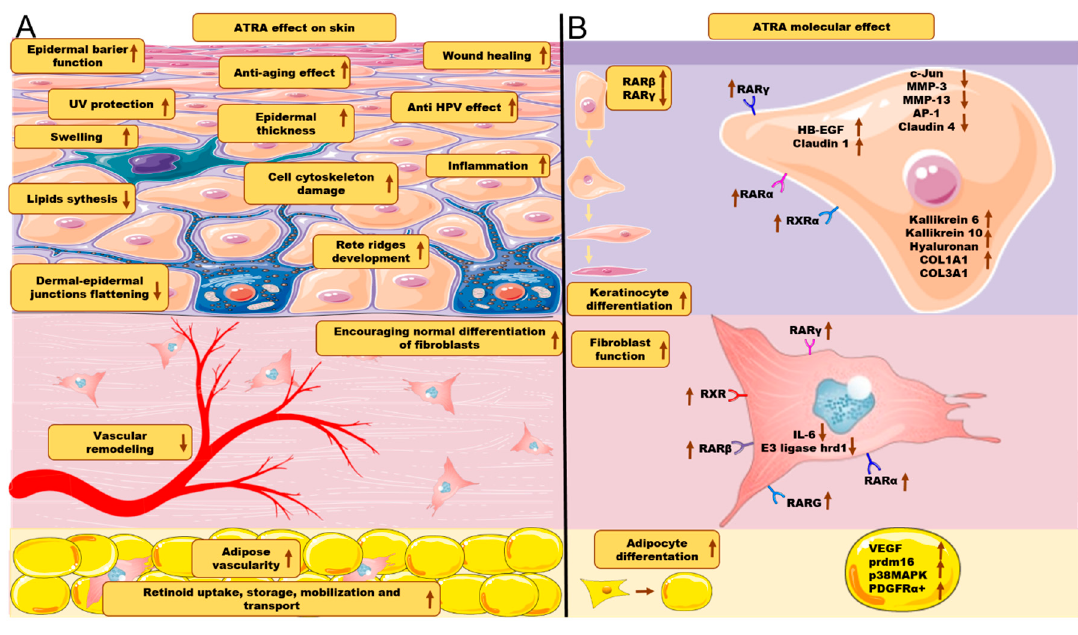
Figure 3. ( A ) ATRA effect on skin layers and skin cells. ( B ) ATRA molecular effects. Arrows directed upwards represent either increase or upregulation. Arrows directed downwards represent either decrease or downregulation. The figure was created using SMART (Servier Medical ART) modified graphics, licensed under a Creative Commons Attribution 3.0. Generic License.